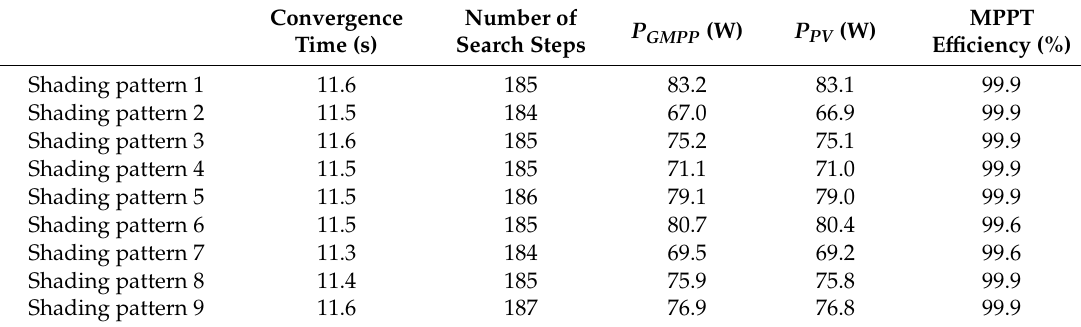
Table 6. The simulation results of the PSO-based GMPPT method for various shading patterns. Convergence Time